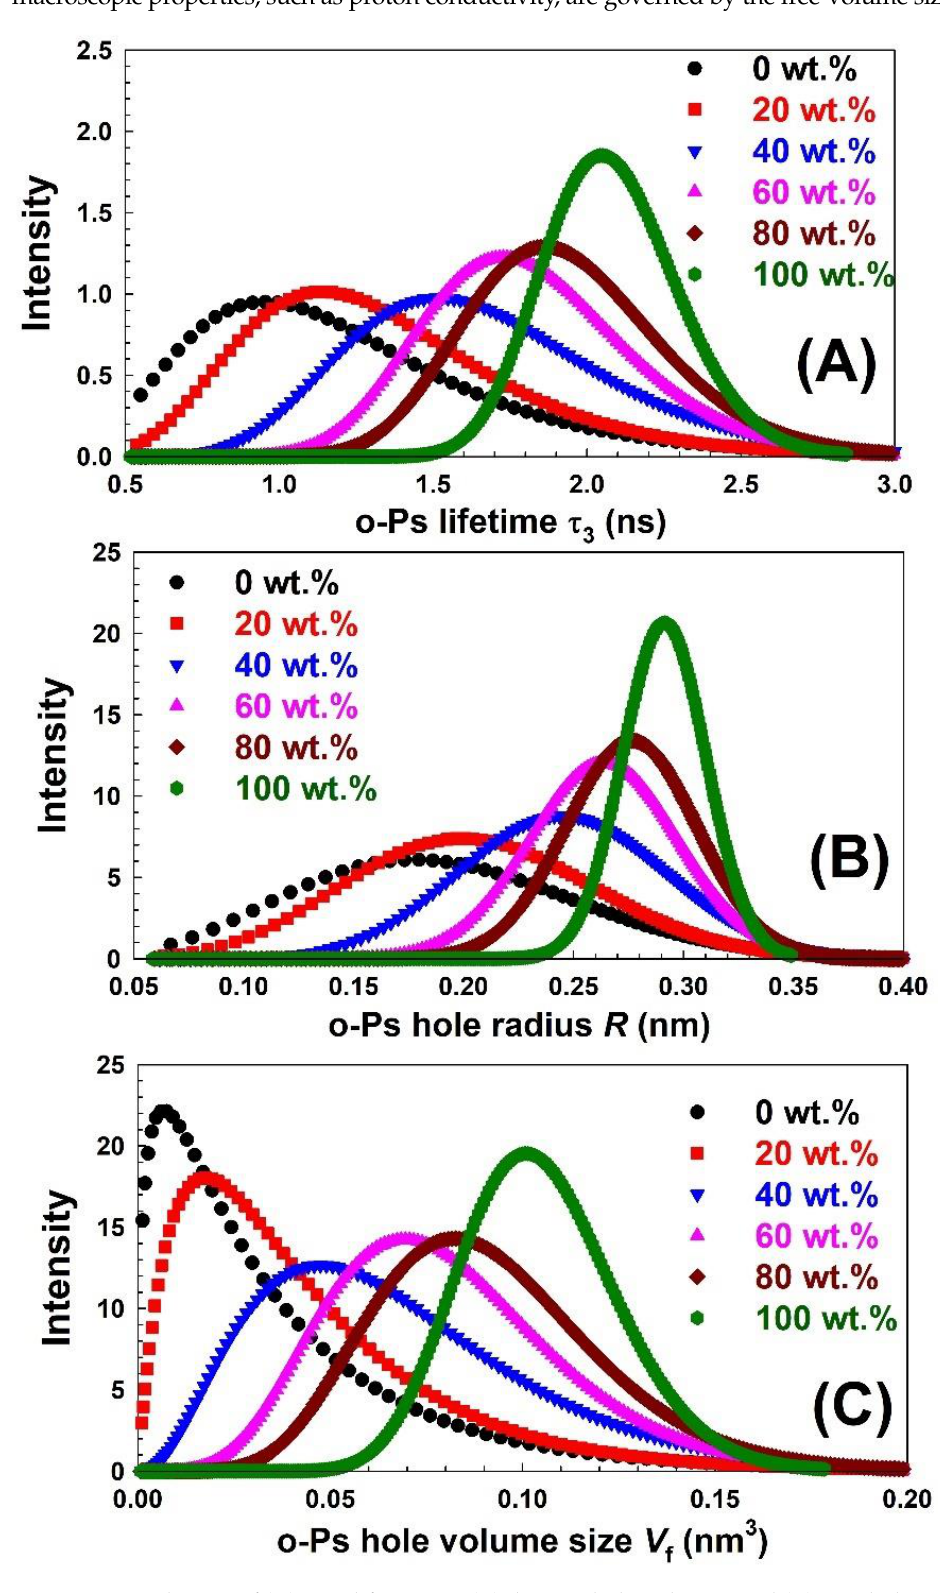
Figure 9. Distribution of ( A ) o-Ps lifetime τ 3 , ( B ) the o -Ps hole radius R , and ( C ) o -Ps hole volume size V f for the PVA blended with different concentrations of Nylon-6,6 deduced using LT10 pro- gram.